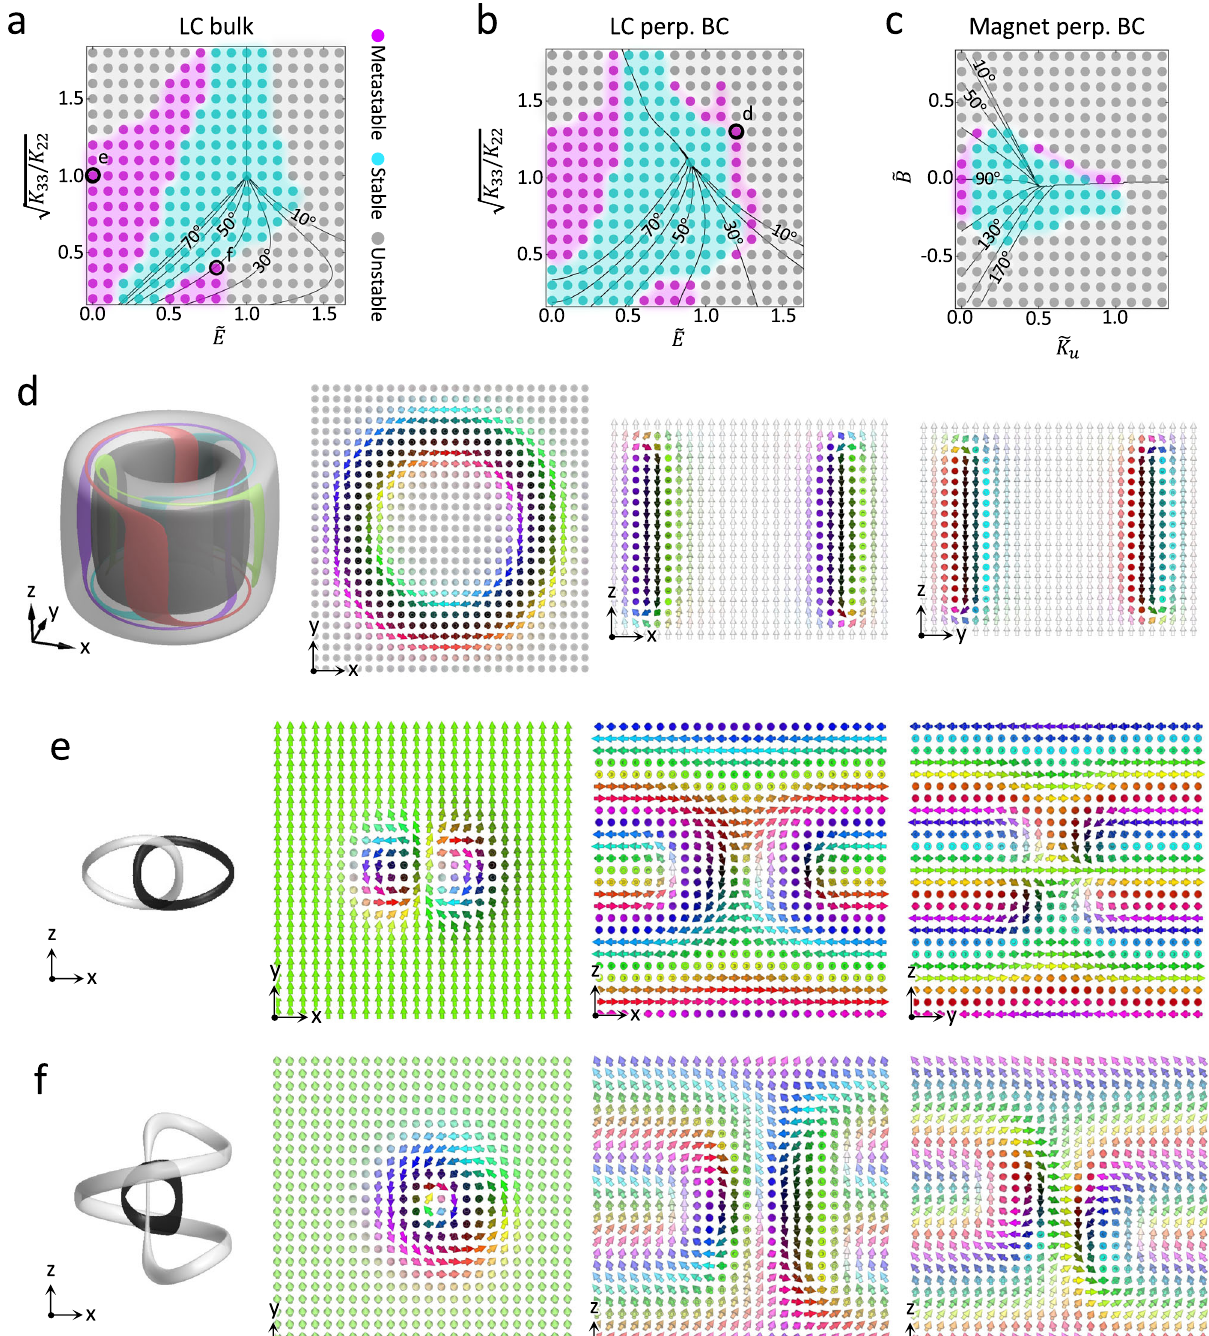
Fig. 2 Structural stability of Hopf solitons. a – b Structural stability diagrams of LC Hopf solitons in the bulk ( a ) and within a con fi ned volume with perpendicular BC and d ¼ 3 p 0 ( b ). The data points are colored based on the stability of Hopf solitons, and the contour lines of background mid-plane cone angle θ c are shown on each diagram. n ð r Þ of labeled data points in ( a – b ) are shown in ( d – f ). c Structural stability diagram of magnetic Hopf solitons in a con fi ned volume with perpendicular BC and d ¼ 3 λ . d – f , Preimages and director fi elds of representative Hopf solitons in a uniform ( d ), helical ( e ), and conical background ( f ), respectively. Preimages and vectors are colored based on the color scheme shown in Fig. ffiffiffiffiffiffiffiffiffiffiffiffiffiffiffiffiffi p = K the background fi eld in the structural stability diagram. In these with K > 1 : 5 16 . Hopf solitons can also be metastable in ffiffiffiffiffiffiffiffiffiffiffiffiffiffiffiffiffi p 33 22 parts of the diagram, the Hopf solitons fi ll the computational ≲ 40 (cid:3) at = K ≤ 0 : 4 K the bulk conical background for 30 (cid:3) ≲ θ c 33 22 volume and form stable crystalline assemblies (Fig. 2a). The e and 0 : 5 ≤ E ≤ 0 : 8 (Fig. 2a, f). Excitingly, Hopf solitons are found to lower-than-background energy of Hopf solitons results from the have n ð r Þ with lower energy than their embedding backgrounds unconstrained structural degrees of freedom in the solitonic between patches of parameter regions of metastable Hopf solitons structures, which become lower in energy density in the intermediate parameter regions than the background states and across the helical-uniform and helical-conical boundaries for